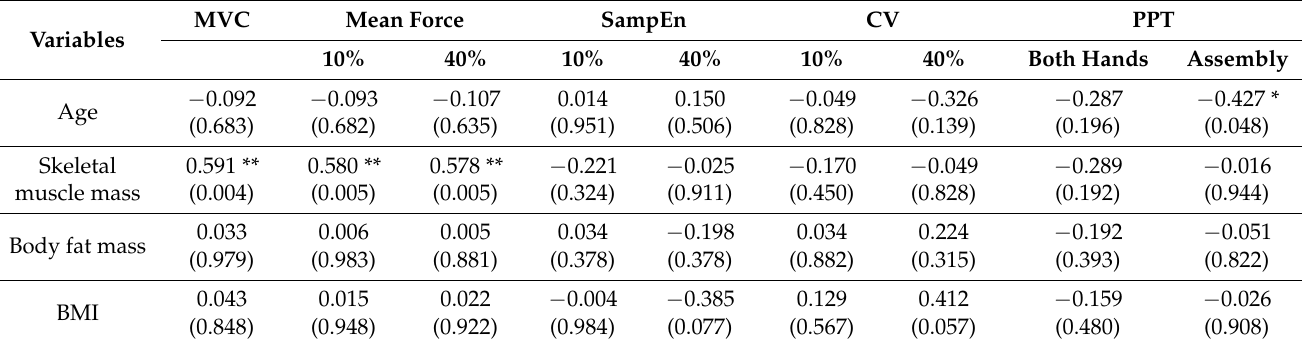
Table 2. Correlation findings between age, body composition, and bimanual motor functions.